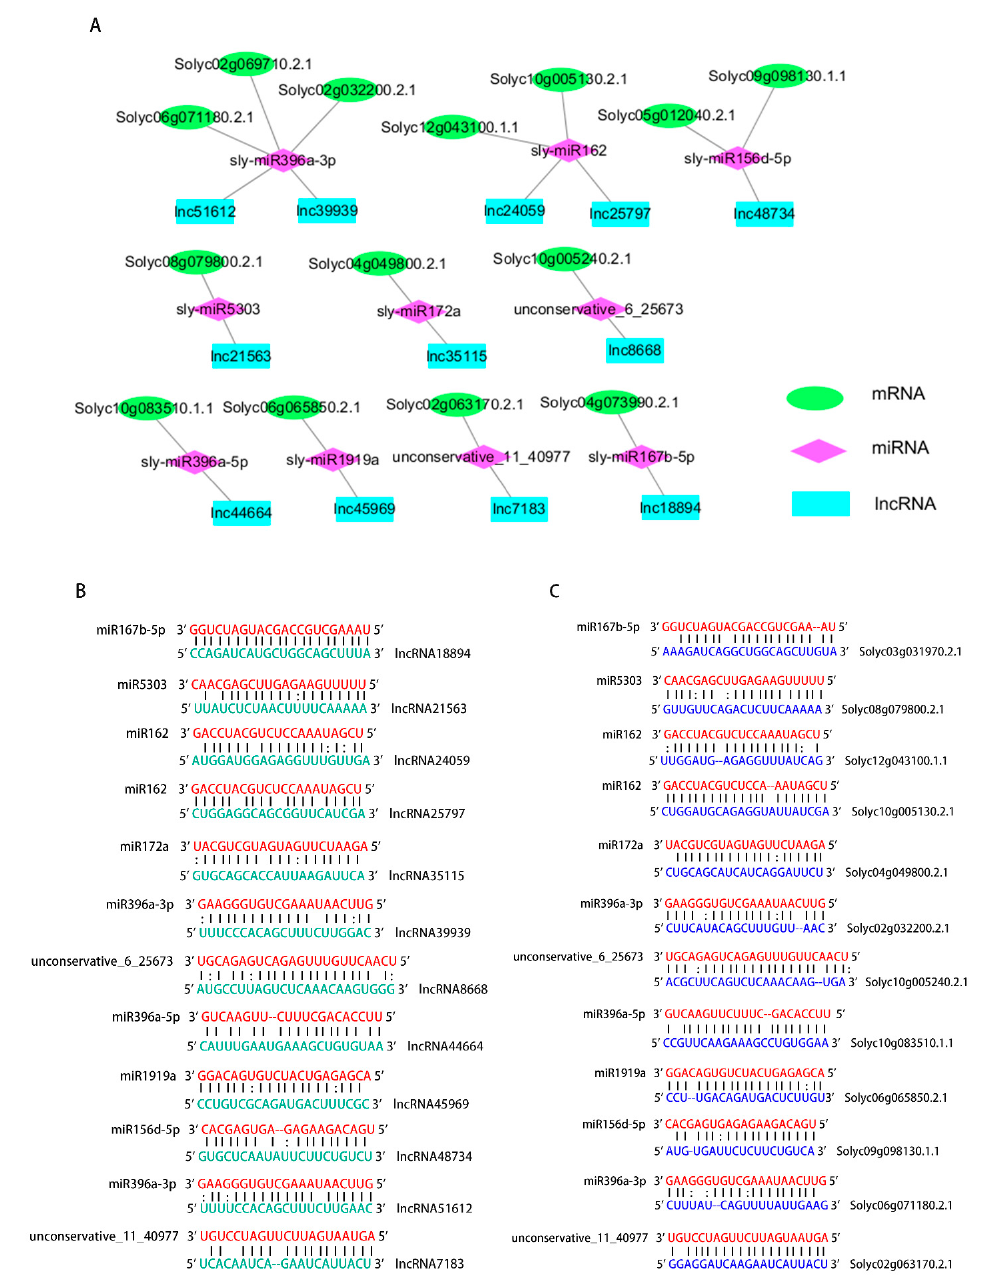
Figure 4. Predicted miRNA targets and endogenous target mimcs from lncRNAs and mRNAs. ( A ) ceRNA network of the lncRNAs, miRNAs and mRNAs in tomato. The green sequences are tomato mRNAs.The red sequences are tomato miRNAs. The blue sequences are tomato lncRNAs. ( B ) The lncRNAs act as miRNA targets. ( C ) The mRNAs act as endogenous target mimics of miRNAs. The green sequences are tomato lncRNAs. The red sequences are tomato miRNAs. The blue sequences are tomato mRNAs. All mRNAs, miRNAs and lncRNAs were assessed using psRNATarget and